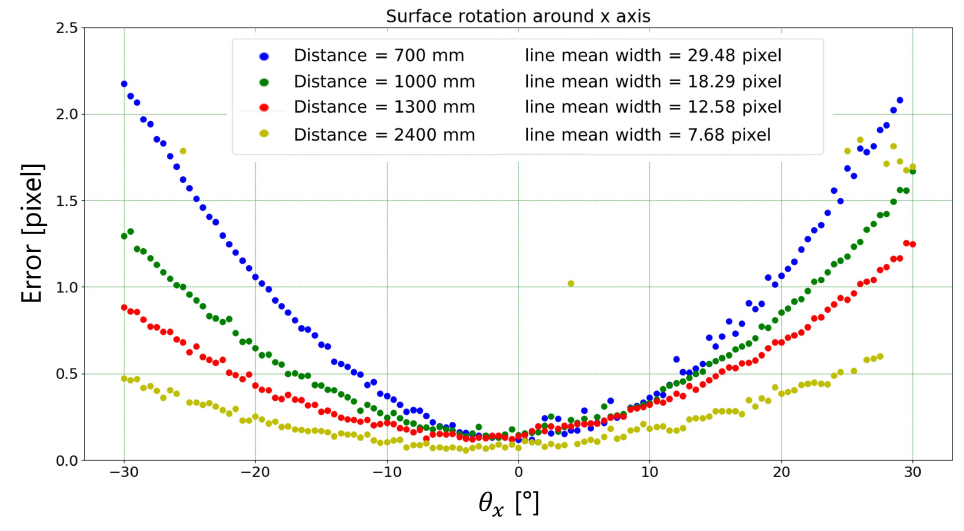
Figure 18. Absolute error (i.e., difference between mean width measured by the proposed algo- rithm and the target width) in pixels for each rotation angle (around x axis) and each working distance